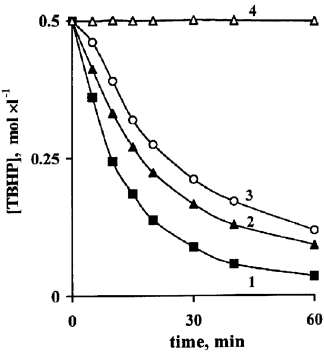
Figure 4: Catalytic performance of Ag/MoO , (2) MoO (3), in the epoxidation of 1-octene with TBHP at 100 o C. The amounts of 3 3 reactants and catalysts: 4 mL (25 mmol) of 1-octene, 0.5 mL (5 mmol) of TBHP, 5.5 mL of chlorobenzene, 0.01 g of catalyst.